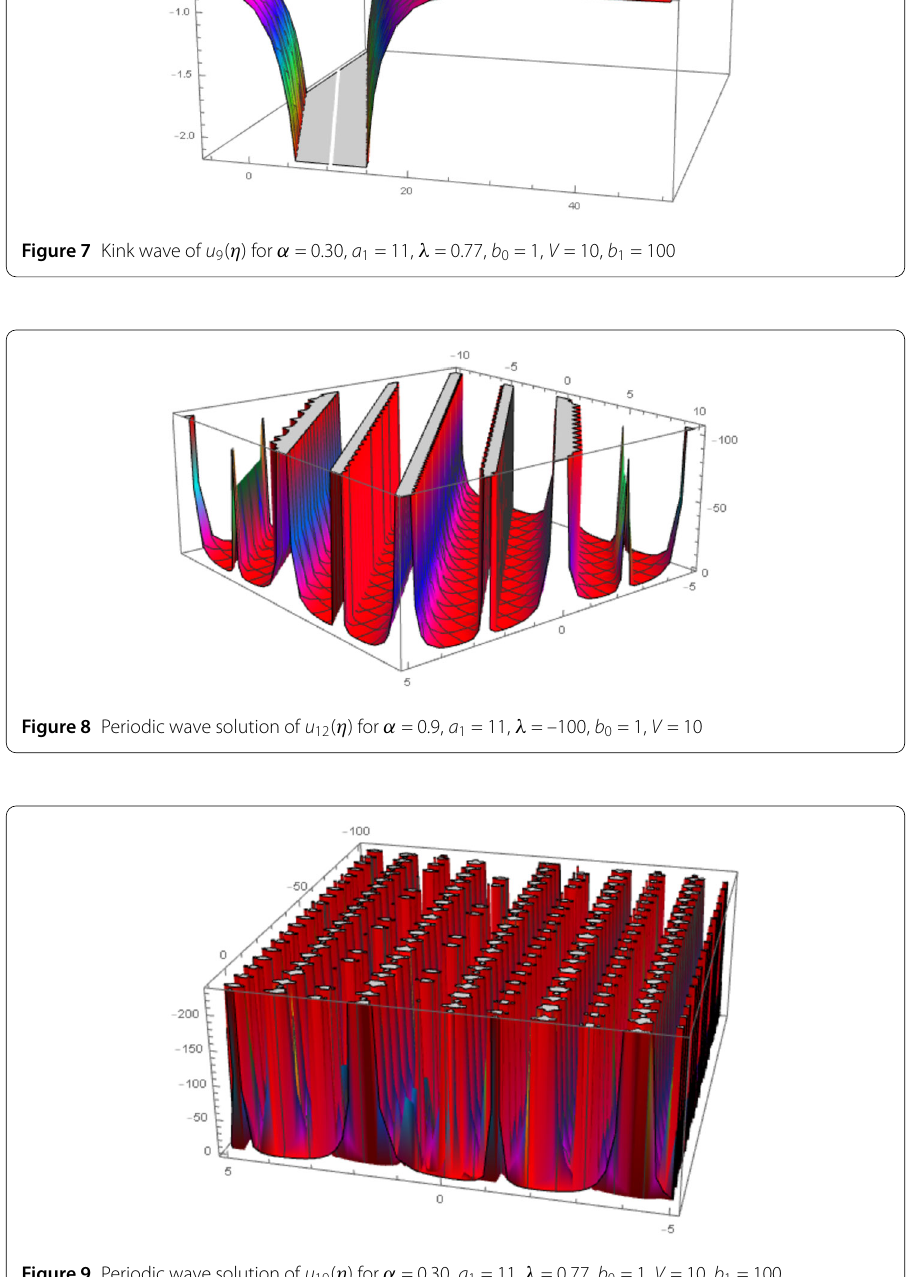
Figure 9 Periodic wave solution of u 19 ( η ) for α = 0.30, a 1 = 11, λ = 0.77, b 0 = 1, V = 10, b 1 =